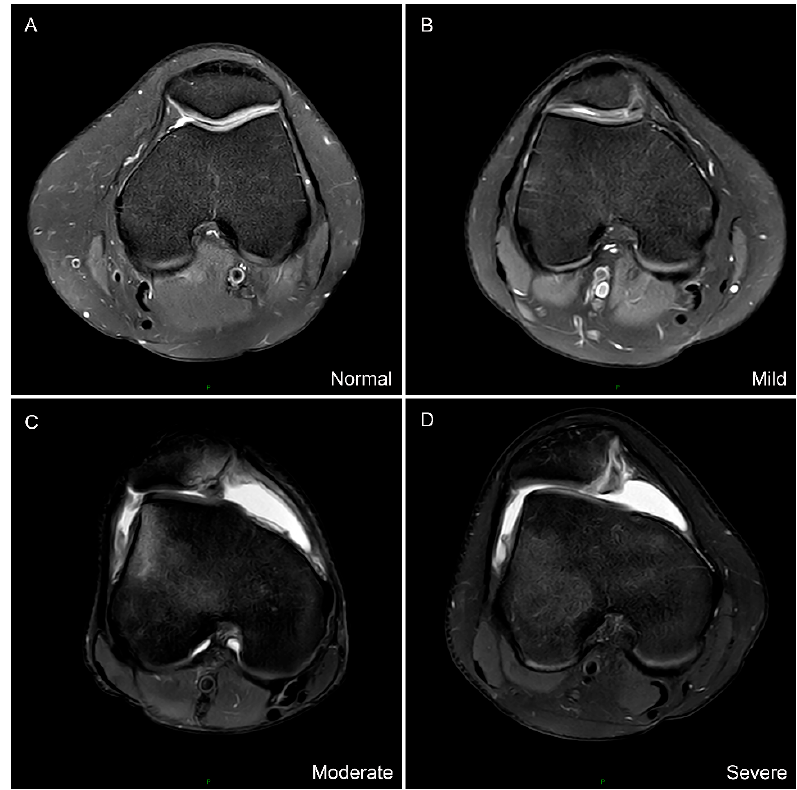
Figure 3. The Oswestry-Bristol classification of trochlear dysplasia. ( A ) Normal femoral trochlea. ( B ) Mild represents shallow trochlea. ( C ) Moderate represents flat trochlea. ( D ) Severe represents convex trochlea.